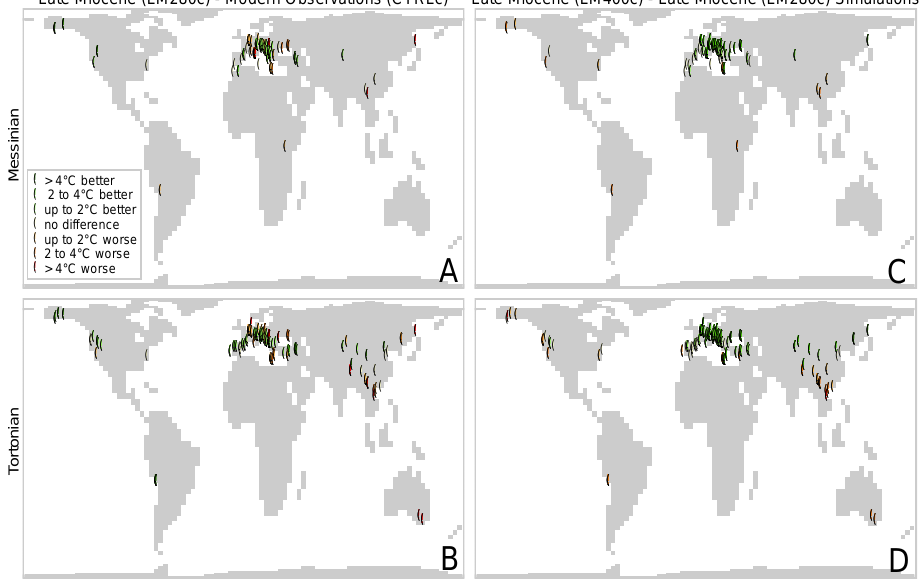
Fig. 10. Improvements in the model–data comparison for mean annual temperature. The lefthand column (A, B) shows the improvement that the late Miocene palaeogeography makes to the model–data comparison. The righthand column (C, D) shows the improvement that higher CO 2 makes to the model–data comparison. Green circles indicate an improvement; red circles indicate a deterioration. The datapoints showing “no difference” are plotted underneath the other datapoints in order to highlight the differences. Table 3. Results from the model–data comparison for high and low CO 2 concentration assumptions.